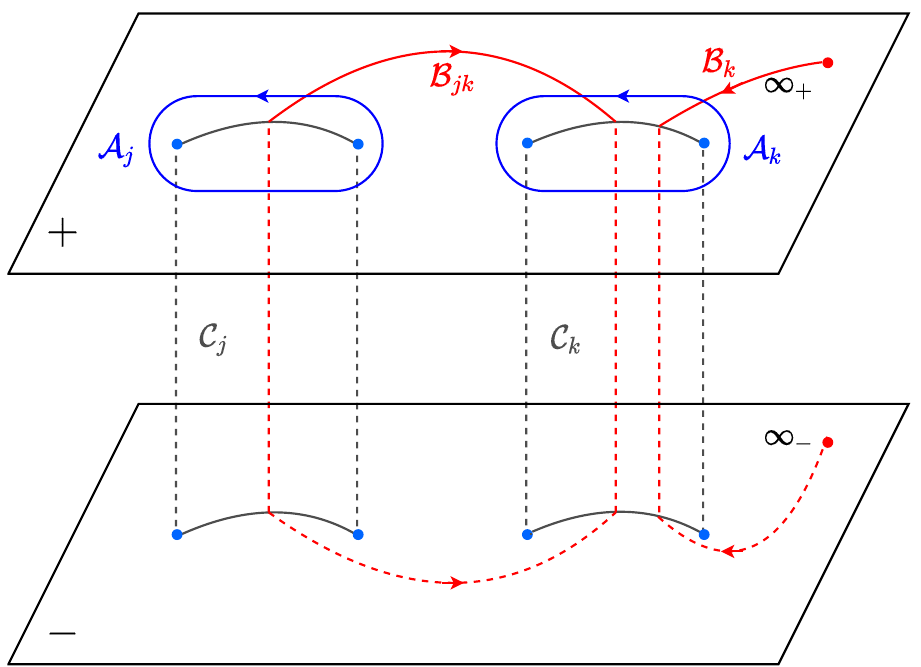
Figure 2: Cycles on a two-sheeted Riemann surface, illustrated on an example of two cuts C and C . Upon tunnelling to the other Riemann sheet, the integration j k orientation is reversed [ 12 ]